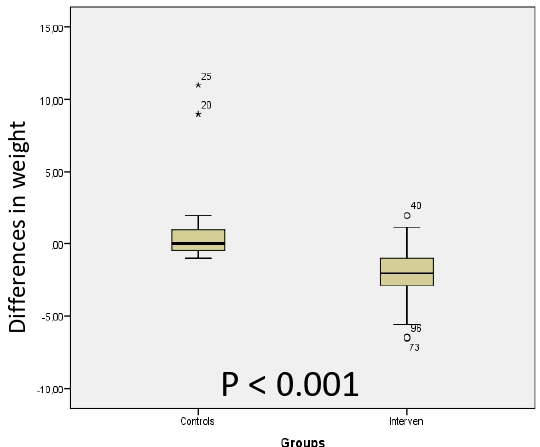
Figure 1. Comparison between the control and intervention group of the differences in weight between week 4 and baseline after introduction of a starch- and sucrose-reduced diet. Mann–Whitney U test. P < 0.05 was considered statistically significant.